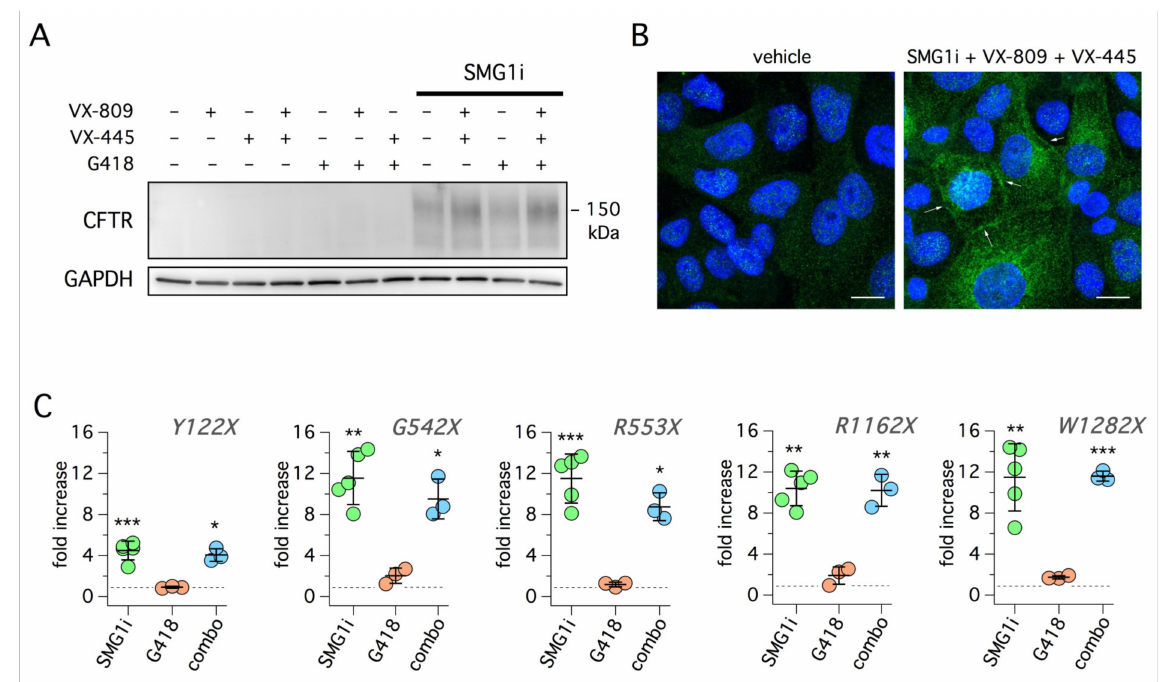
Figure 8. Molecular analysis of SMG1i effects. ( A ) Representative Western blot experiment performed on 16HBE14o- cells expressing W1282X-CFTR. Cells were treated for 24 h with the different combinations of indicated compounds. Treatment with SMG1i (1 µ M) was required to evoke the appearance of CFTR protein. The apparent molecular size of the rescued protein is smaller than wild-type CFTR, in agreement with the presence of the truncating mutation. ( B ) Representative confocal microscopy images obtained from 16HBE14o- cells expressing W1282X-CFTR mutation under control condition or after treatment with SMG1i (1 µ M) + VX-809 (1 µ M) + VX-445 (5 µ M). CFTR expression and localization was detected by staining with a specific antibody (green signal). Treatment causes the appearance of CFTR signal in the cytosol and at the plasma membrane (arrows). Nuclei (DAPI staining) are shown in blue. Scale bar: 10 µ m. ( C ) Results of real-time RT-PCR experiments to evaluate CFTR mRNA levels in 16HBE14o- cells with the indicated mutations. Before RNA extraction, cells were treated for 24 h with G418 (0.5 mg/mL), SMG1i (1 µ M), or with the combination of the two compounds (combo). The scatter dot plots show CFTR transcript fold-change relative to control condition for every mutation. All values were normalized to B2M. The p value was determined using one-sample t-test. *, p < 0.05; **, p < 0.01; ***, p < 0.001 vs. control (dashed